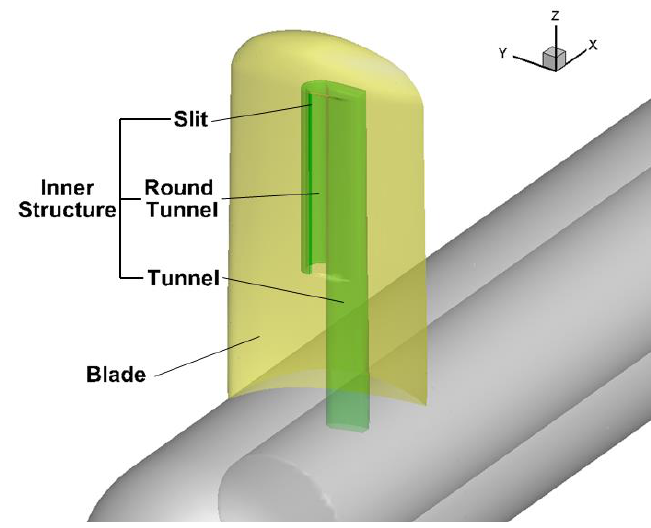
Figure 13. The names of each part of the Coanda propeller.